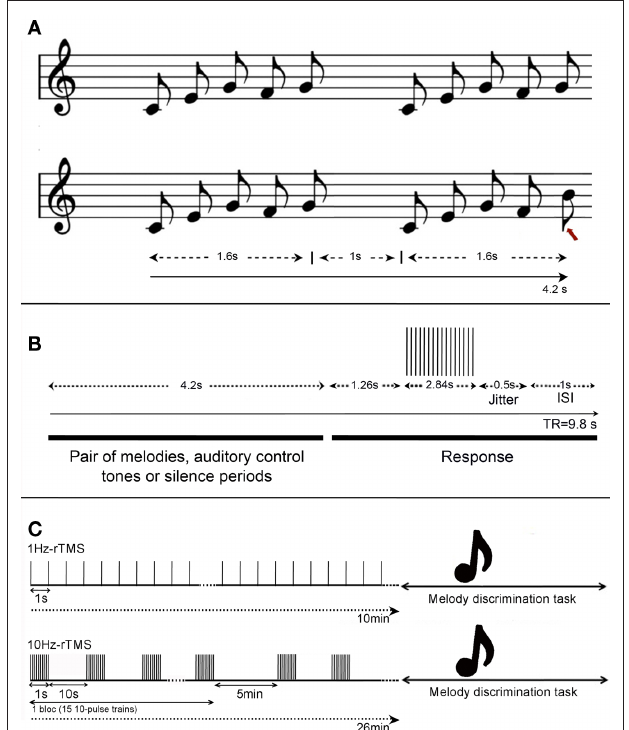
Figure 1 | (A) Task design. Example of auditory stimuli in the melody discrimination task. Each melody was composed of five 0.32 s-notes lasting 1.6 s (0.32 × 5), and each trial consisted of pairs of melodies separated by 1 s, lasting 4.2 s in total (i.e., 1.6 + 1.6 + 1). (Top) Example of a trial composed of two identical melodies; (bottom) example of a trial composed of two different melodies. The red arrow indicates melody alteration that is a difference in pitch occurring in one of the two final tones of the sequence. Participants had to indicate if the pairs of melodies were the same or different by pressing left or right buttons respectively. (B) Design for the fMRI experiment. Timeline of events during each fMRI trial. Each pair of melodies (or auditory control tones or silence periods) lasted 4.2 s and was followed by a constant 5.6 s including 1.26 s of silence, 2.84 s of data acquisition, 1 s of ISI, and a 0.5-s jitter was added to each stimulus duration to maximize the detection of the BOLD response to the task. (C) Design for the TMS experiment. Frequencies at 1 or 10 Hz-rTMS were applied off-line, i.e., preceding the melody discrimination task. (Top) 1 Hz-rTMS was applied during 10 min (600 pulses), and (bottom) 10 Hz-rTMS was applied in four blocks of 150 pulses each (i.e., 15 trains of 10-pulse of 1-s duration), totalizing also